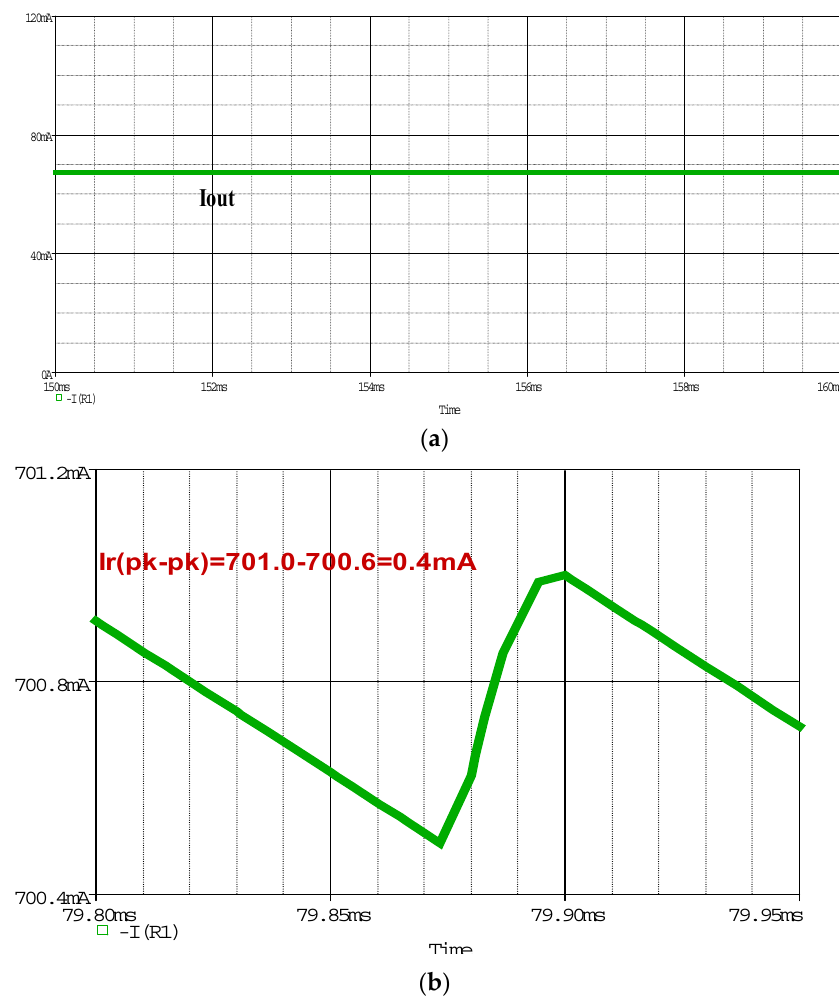
Figure 15. ( a ) Output current waveform. ( b ) Magnitude of output ripples for proposed converter.